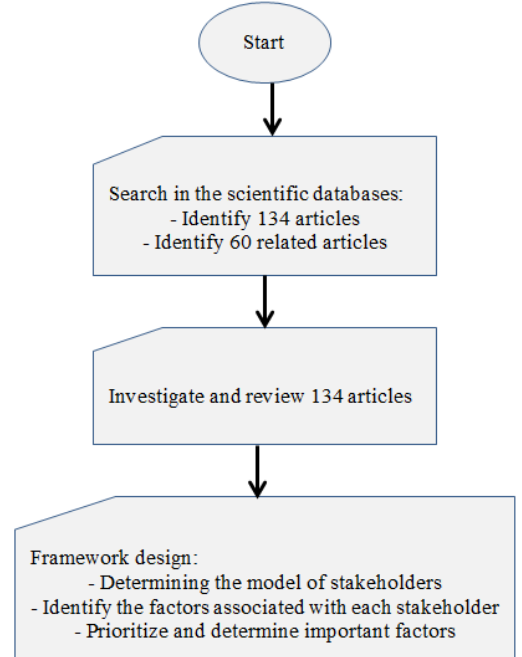
Figure 8. Research methodology flowchart